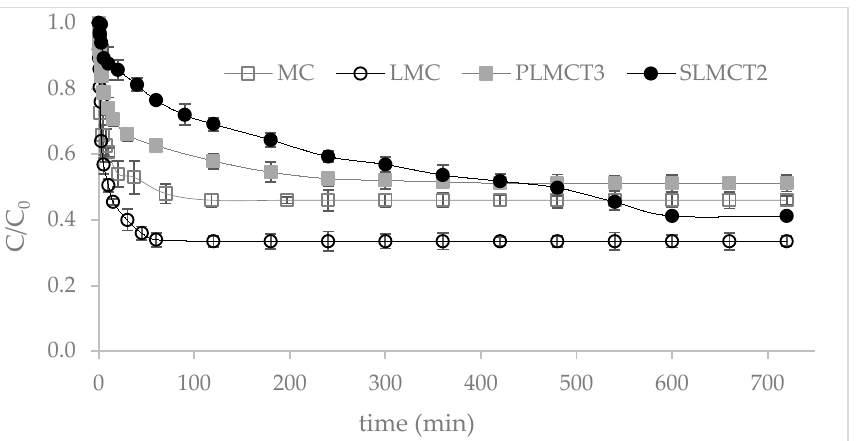
Figure 9. Phosphate adsorption kinetic of the adsorbents. Values obtained at V: 25 mL, w: 0.25 g and C i : 25 mg·L − 1 PO 43 − ; except for SLMCT 2 w: 10 ± 0.2 g and V: 120 mL.